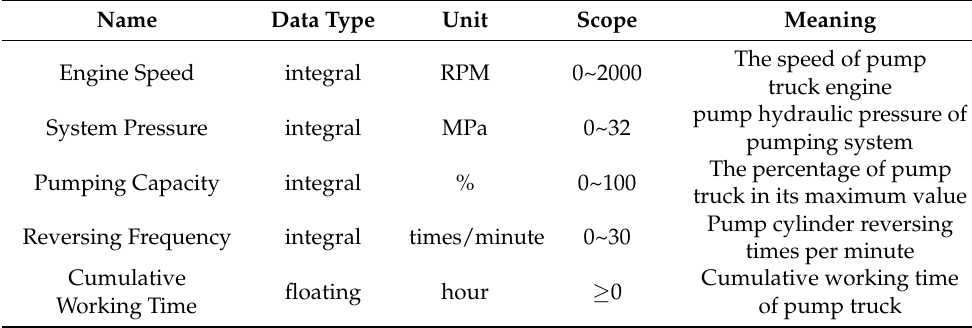
Table 1. Meanings of condition monitoring data of the concrete pump